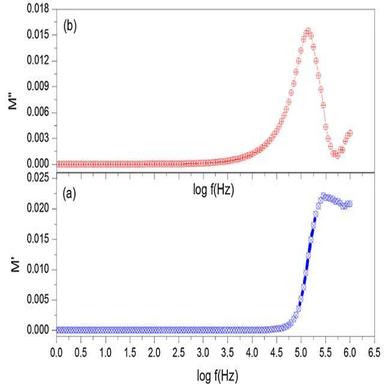
Frequency dependent variations of real part M′ and imaginary part M″ for PCOH.